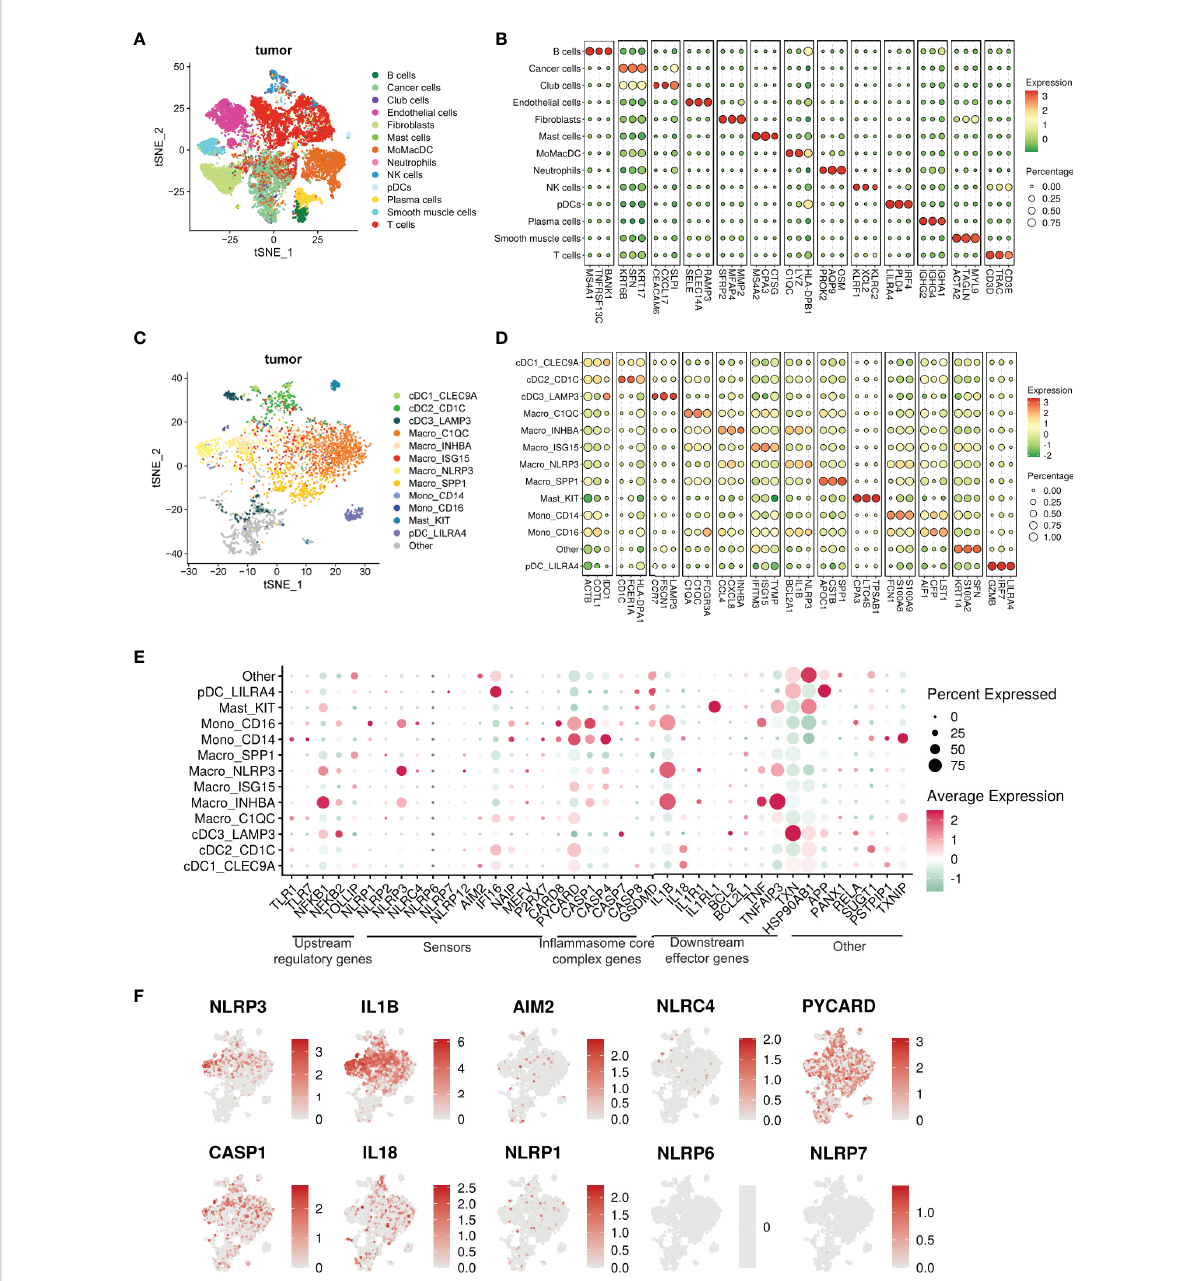
FIGURE 4 Single cell transcriptomic atlas reveals a heterogenous tumor in fi ltrating myeloid cell landscape with differential in fl ammasome signatures in each subtype. (A) tSNE plot showing the transcriptome landscape of 19,193 cells in the TME from patients with HNSCC (n=6). Colors indicate cell types. (B) Bubble heat map showing relative expression levels of typical signature genes for all cell types shown in panel (A). (C) tSNE showing the subtypes of 3072 myeloid cells (subset of the entire cell population) in the tumor excluding neutrophils, divided into 13 different subclusters. The “ other ” subset could not be characterized. ” tSNE showing the phenotypic heterogeneity of 3072 myeloid cells in the tumor excluding neutrophils, divided into 13 different subclusters. The “ other ” subset could not be characterized. (D) Bubble heat map showing expression levels of selected signature genes for the tumor in fi ltrating myeloid cell populations shown in panel (C) (E) Bubble heat map showing relative expression of in fl ammasome pathway genes in the tumor in fi ltrating myeloid cell subclusters. (F) Feature plots showing gene expression of selective in fl ammasome genes in the identi fi ed tumor in fi ltrating myeloid cell populations. Red and gray represent high and low expression